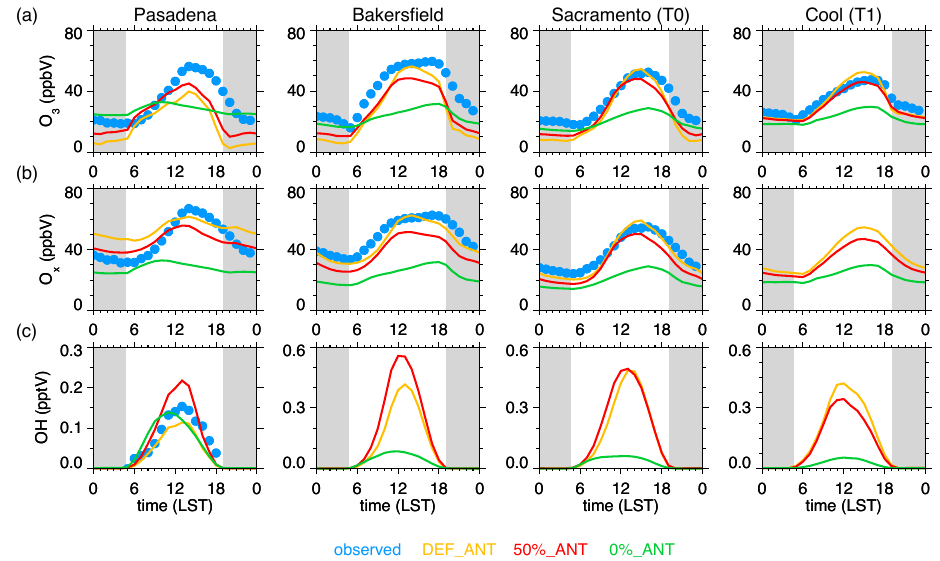
Figure 5. Observed and simulated diurnally averaged (a) ozone (O 3 ) , (b) O x (O 3 + NO 2 ) , and (c) OH over the 2-month period at the (a) Pasadena, Bakersfield, T0, and T1 supersites. Gray shading denotes night. 50%_LBC simulation results not shown since they are nearly identical to those from the 50%_ANT simulation. NO 2 not measured at T1, OH not yet available at Bakersfield, and OH not measured at T0 and T1.